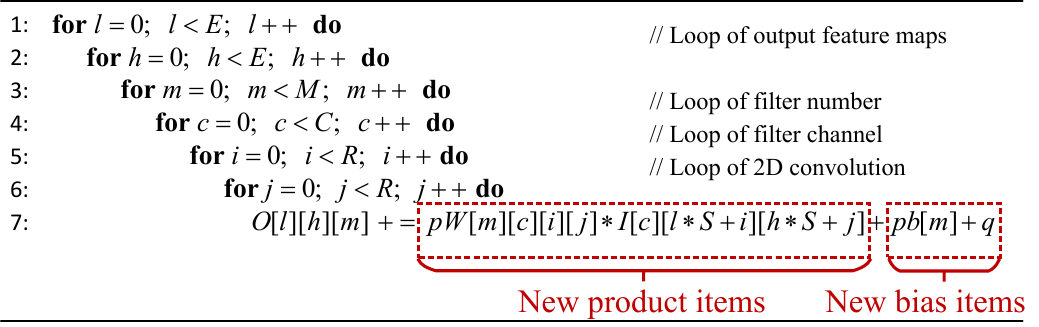
Algorithm Pseudo Code of CONV-BN Layers or FCN-BN Layer s